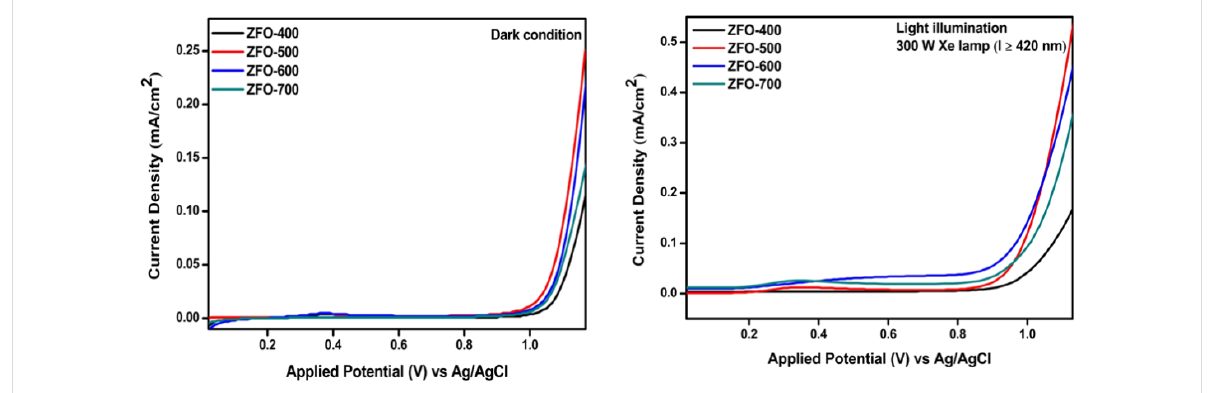
Figure 7: Linear-sweep voltammograms of ZFO-400 to ZFO-700 (a) under dark conditions, (b) under visible-light illumination.